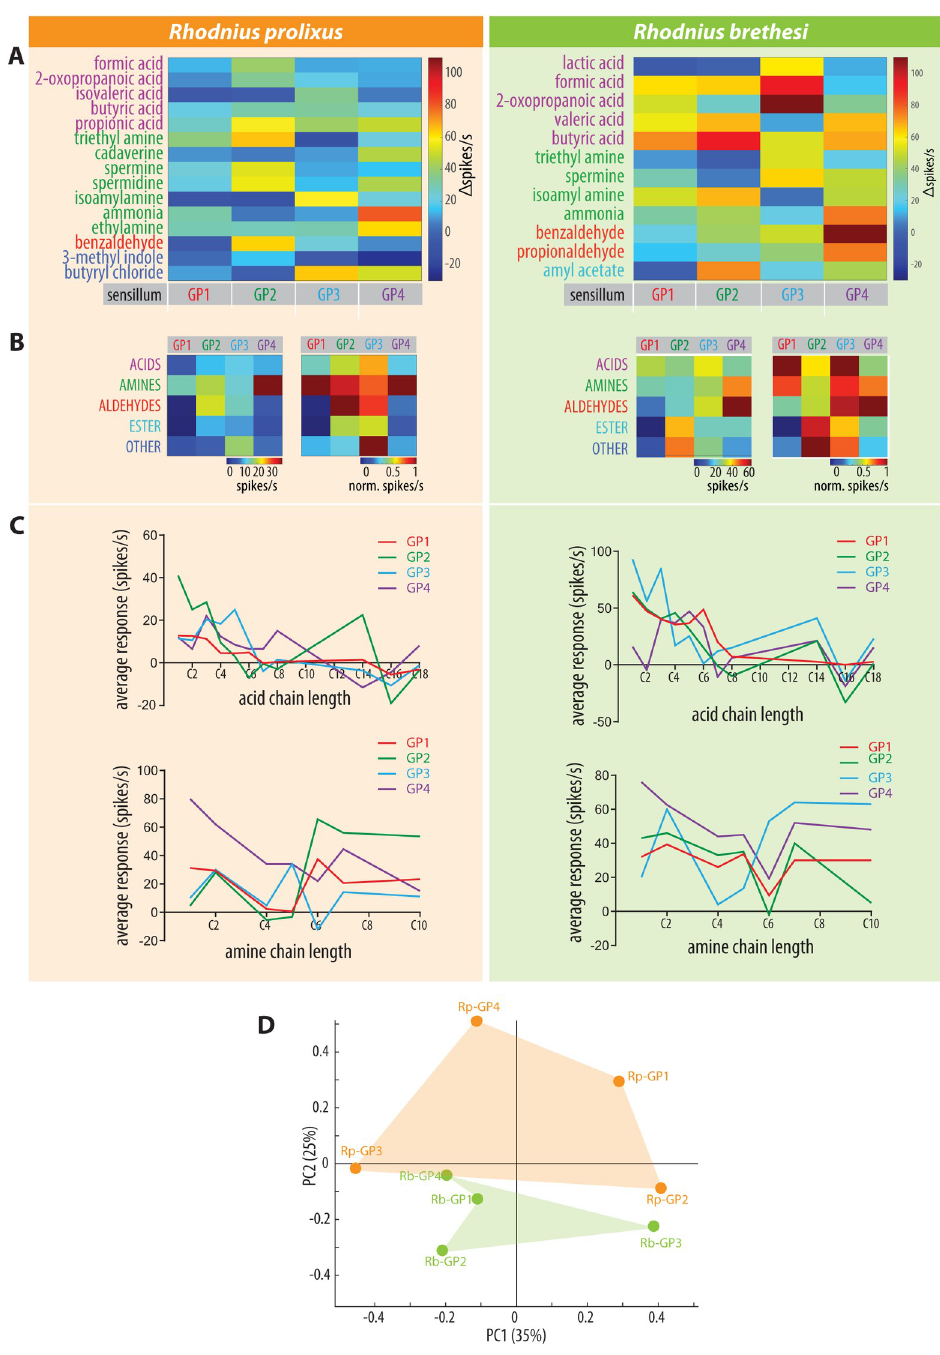
Fig 7. Response profile of the functional subtypes of grooved peg sensilla. (A) Color coded mean responses for the selected diagnostic odors for each sensillum type, for each insect species. Odors were chosen as diagnostic when they allowed the maximum separation between sensillum types. (B) Averaged responses for each chemical class and sensillum type (left panel), normalized to the maxiumum response within each sensillum type (right panel). (C) Averaged responses (n = 2–6) to acids and amines with the indicated carbon chain length. In R . prolixus , GP1, GP3, GP4 show a negative correlation between carbon length and response strength to acids (Pearson correlation; Rp-GP1: r = -0.87, p = 0.0005; Rp-GP2: r = -0.59, p = 0.054; Rp-GP3: r = -0.75, p = 0.008; Rp-GP4: -0.61, p = 0.045, n = 11). In R . brethesi GP1 and GP2 show a significant negative correlation between carbon length and response strength to acids (Pearson correlation; Rb-GP1: r = -0.89, p = 0.0002; Rb-GP2: r = -0.76, p = 0.006, n = 11). (D) Principal component analysis (PCA) of R . prolixus and R . brethesi sensillum types. No significant difference was observed for the sensillum space of the two species (ANOSIM, p = 0.32,